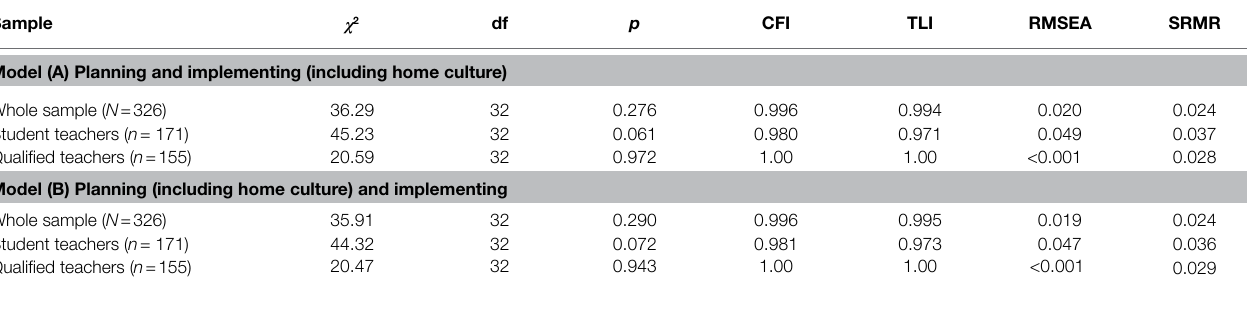
TABLE 4 | Fit indices of Culturally Inclusive Pedagogy: two-factor model. Sample χ 2